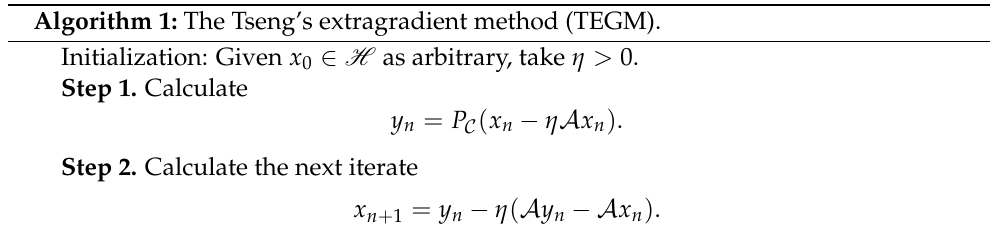
Algorithm 1: The Tseng’s extragradient method